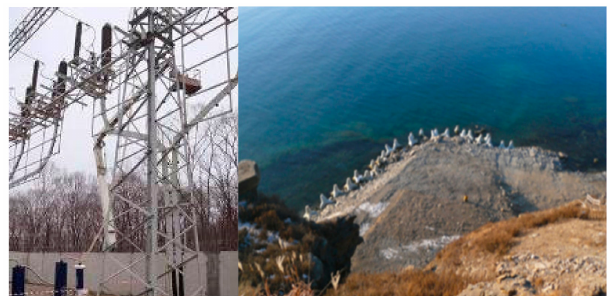
Figure 9. On-site testing of a 220 kV 13.3 km long XLPE cable circuit: The damped AC system HV300 is connected to one of the cable section phases (left) and the transition point between land and submarine cable (right).